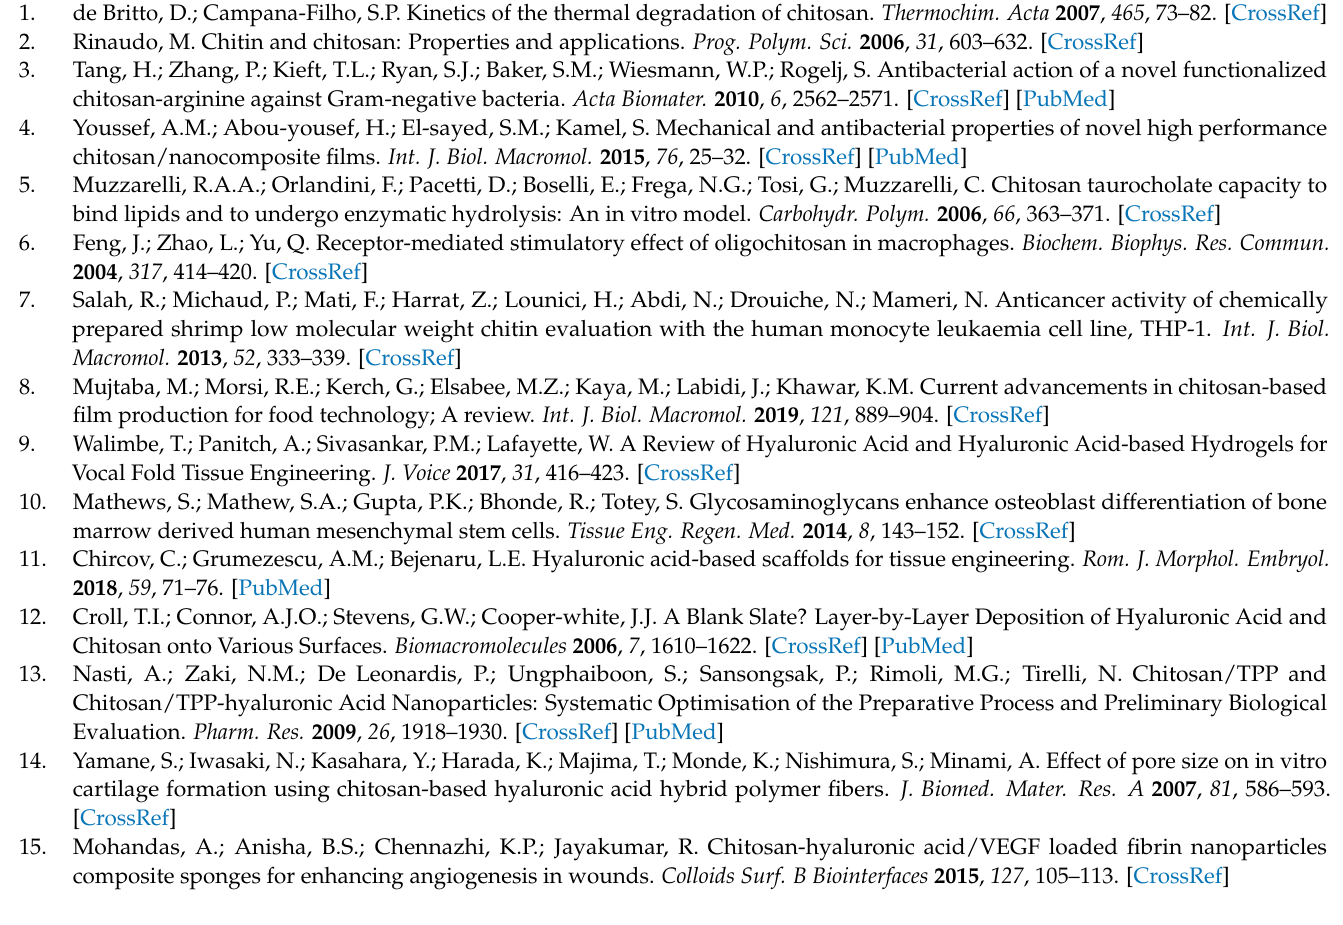
15% and HNa 30%. Figure S2: Pristine CHT Raman spectra. Figure S3: Pristine HNa Raman spectra Figure S4: XPS scans for C, O and N, of chitosan/HNa films. S5 Swelling behaviour of